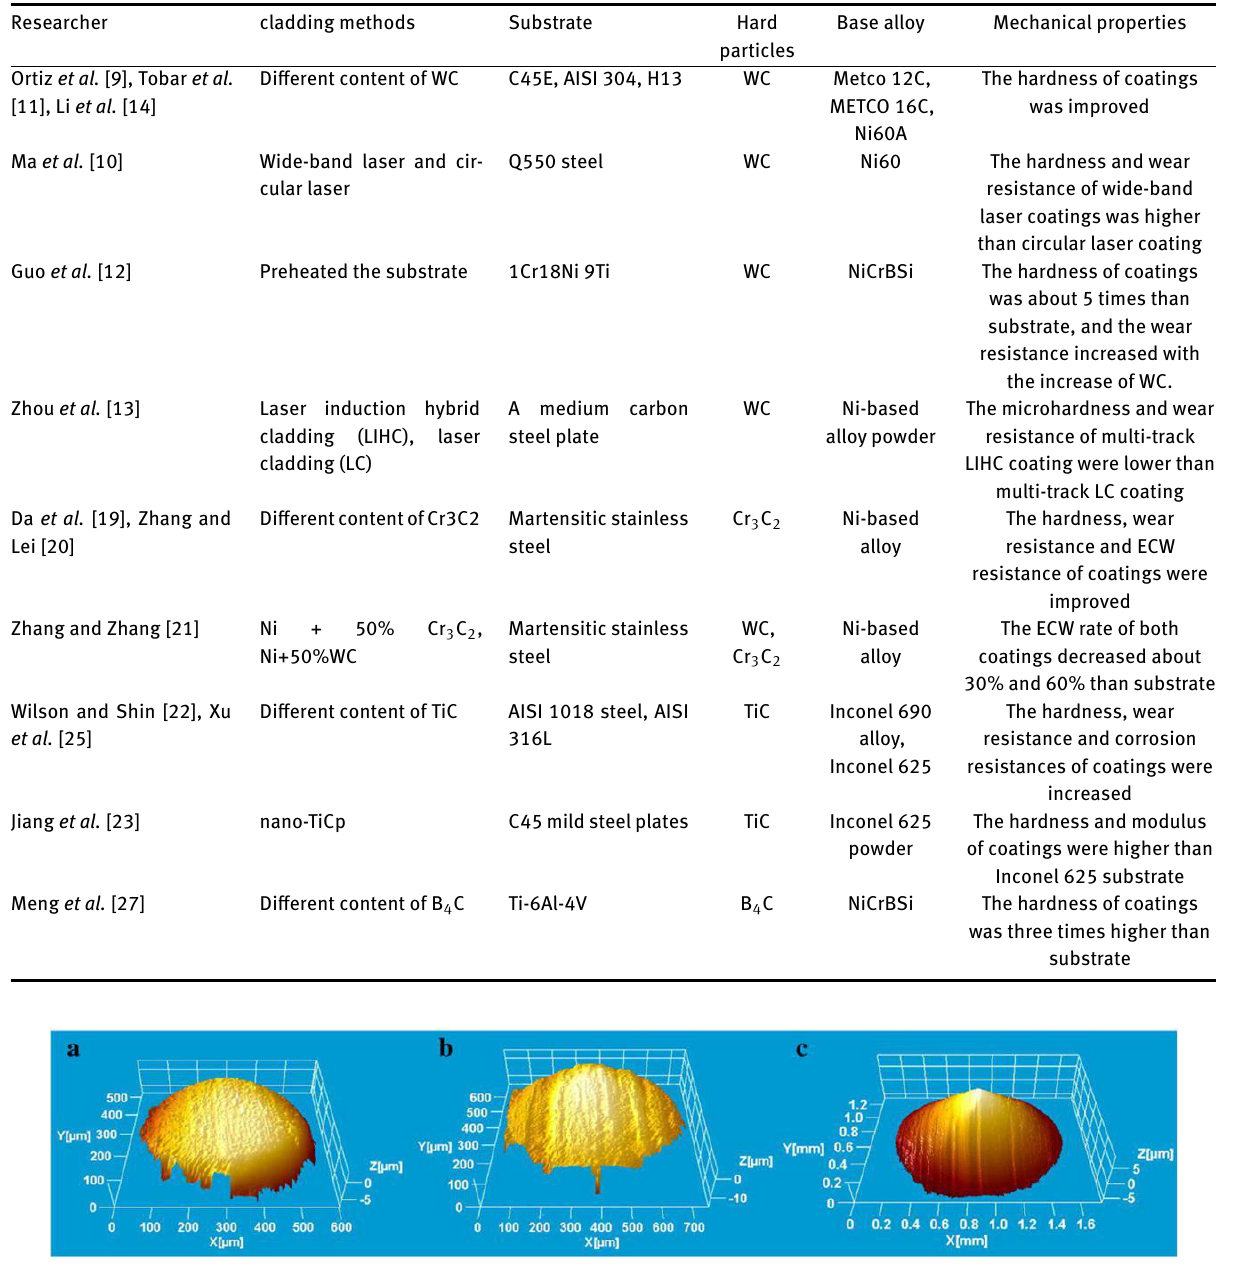
Figure 4: 3D non-contact mapping of worn surface: (a): NiCrBSi coating; (b): NiCrBSi/5%WC-Ni coating; (c): NiCrBSi/50%WC-Ni coating [12]